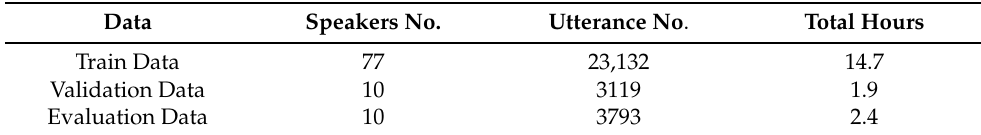
Table 1. FSC dataset